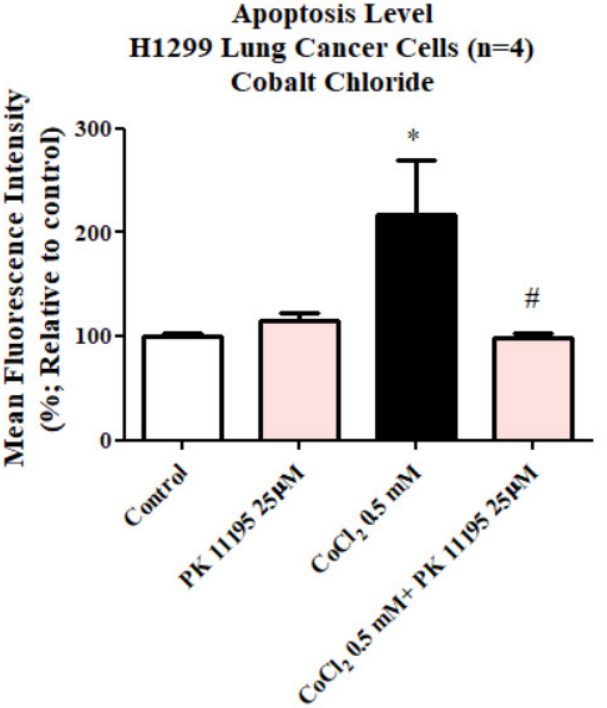
Figure 5. Evaluation of apoptotic cell death levels assessed by apopxin dye following exposure of H1299 for 23 h to 0.5 mM CoCl 2 with or without pretreatment with 25 µM PK 111195. Results are expressed as mean ± SD ( n = 4 replicates in each group). # and * p < 0.05.